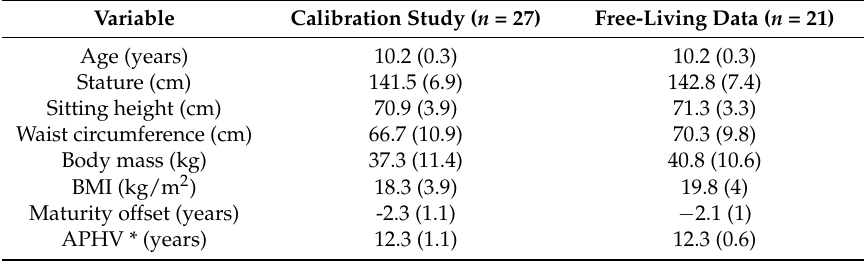
Table 2. Descriptive characteristics of the participants [mean (standard deviation,